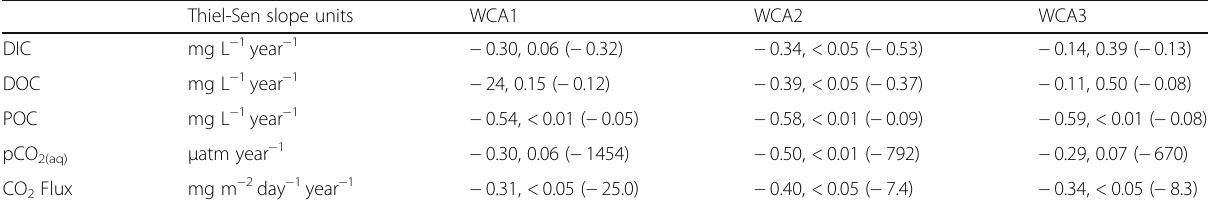
Table 2 Trend analysis results expressed as Kendall ’ s τ , ρ value (Thiel-Sen Slope) for annual mean dissolved inorganic carbon (DIC), dissolved organic carbon (DOC), particulate organic carbon (POC), surface water pCO 2 (pCO 2(aq) ), and CO 2 flux rate for each region of the Everglades Protection Area between water years 1995 and 2015 (May 1, 1994 – April 30,